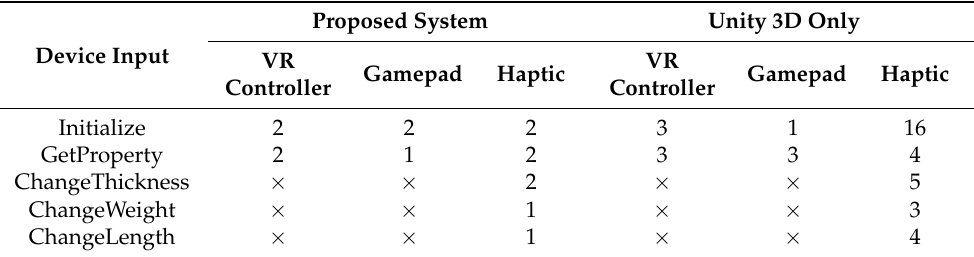
Table 3. Comparison of the speed of command execution with the proposed method with the VR engine only